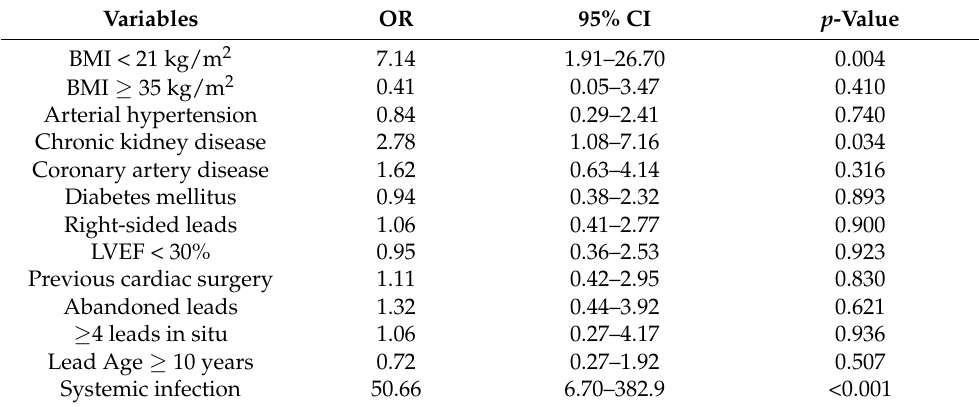
Table 3. Multivariate regression analysis—predictors for all-cause